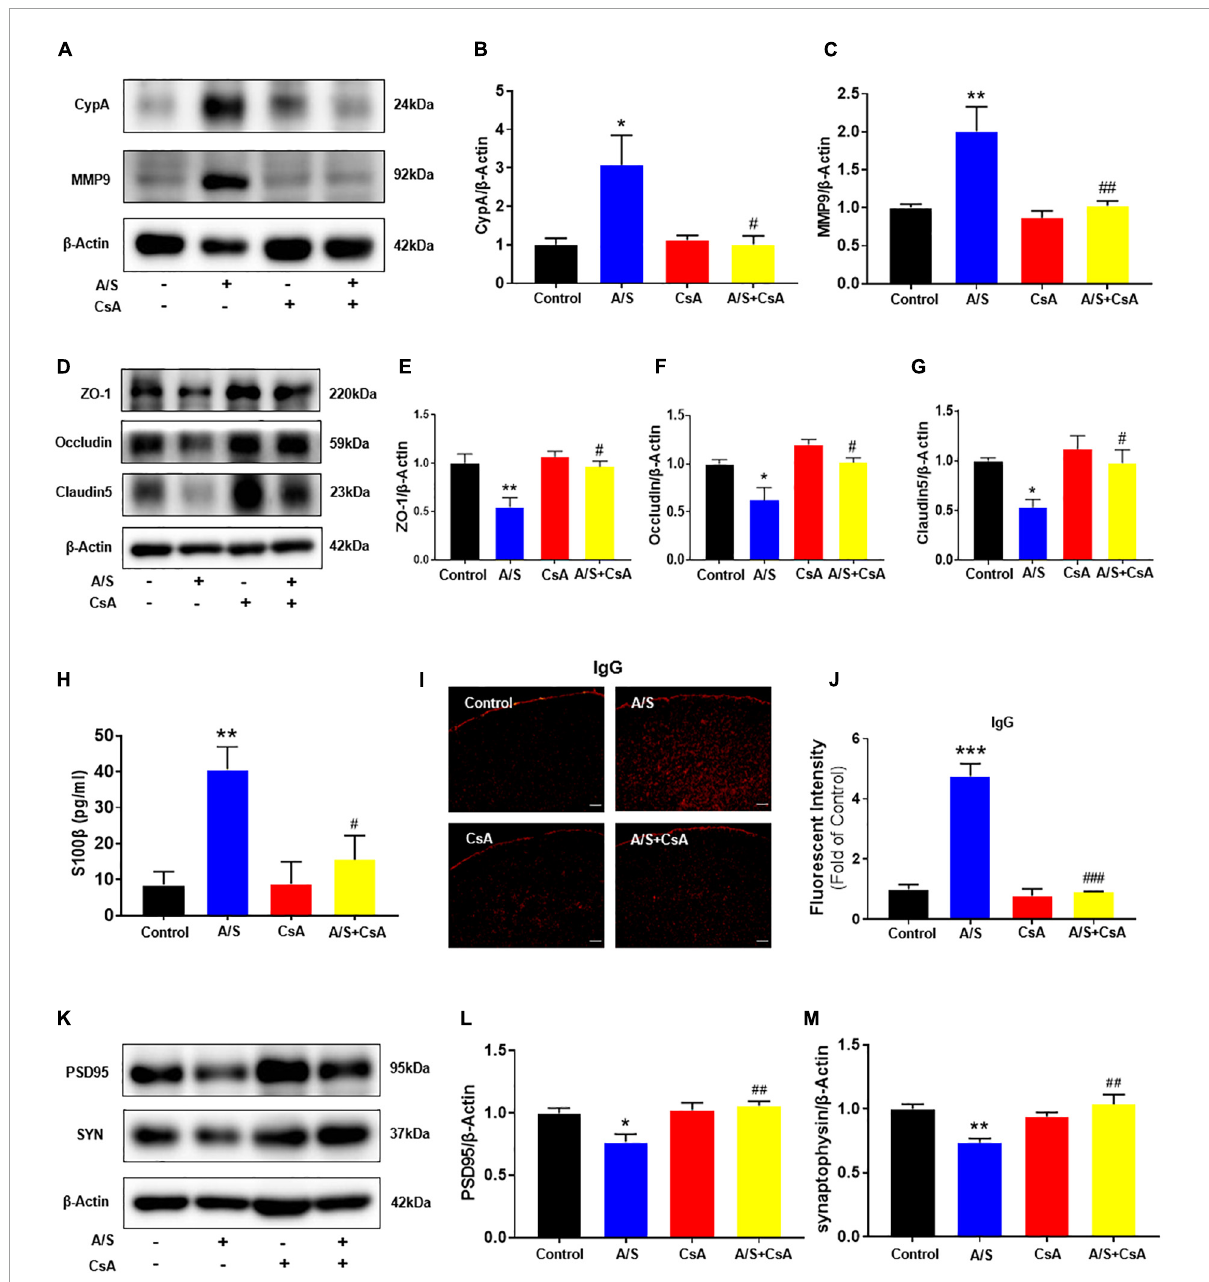
FIGURE4 Effects of CypA/MMP9 pathway on BBB permeability and synaptic plasticity proteins in anesthesia/surgery mice. Inhibition of CypA/MMP9 pathway improves the tight junction (TJ) proteins, attenuates the BBB leakage, and increases synaptic plasticity proteins in anesthesia/surgery mice. The protein levels of CypA, MMP9 (A–C) , ZO-1, occludin, claudin5 (D–G) , PSD95 and synaptophysin (K–M) were assessed by western blotting. S100 β levels in serum were measured by ELISA (H) . IgG leakage staining (red fluorescence) was shown in the cortex (I,J) . Scale bars: 100 µ m. Values are expressed as mean ± SEM and were analyzed by one-way analysis of variance, followed by Tukey’s post-hoc test. n = 3 – 5 per group. A/S, anesthesia/surgery. * P < 0.05, ** P < 0.01, *** P < 0.001, compared to control group; # P < 0.05, ## P < 0.01, ### P < 0.001, compared to A/S